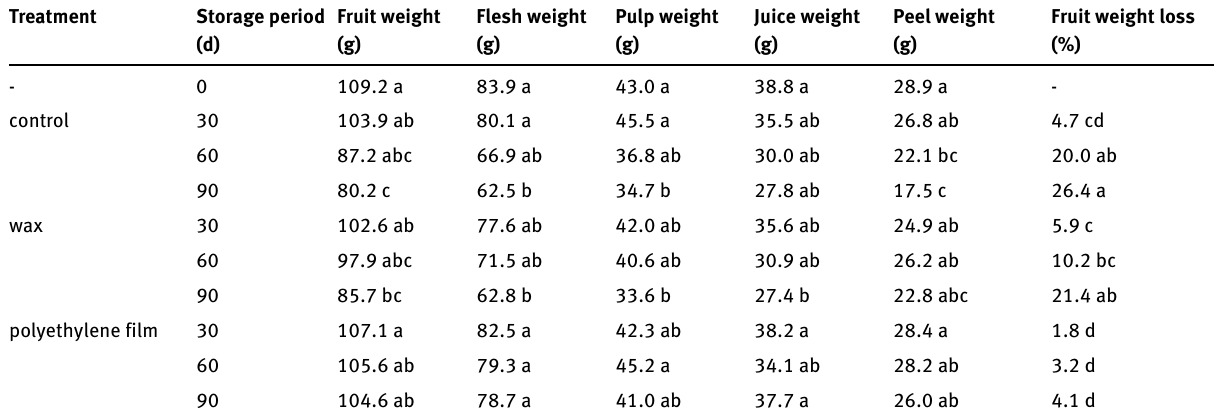
Table 2: Correlation coefficients of fruit quantitative and qualitative traits during 90 days of cold storage